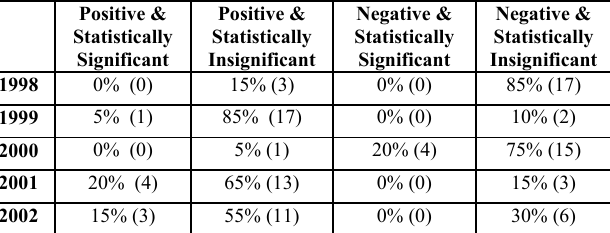
Table 2: APT results according to alpha